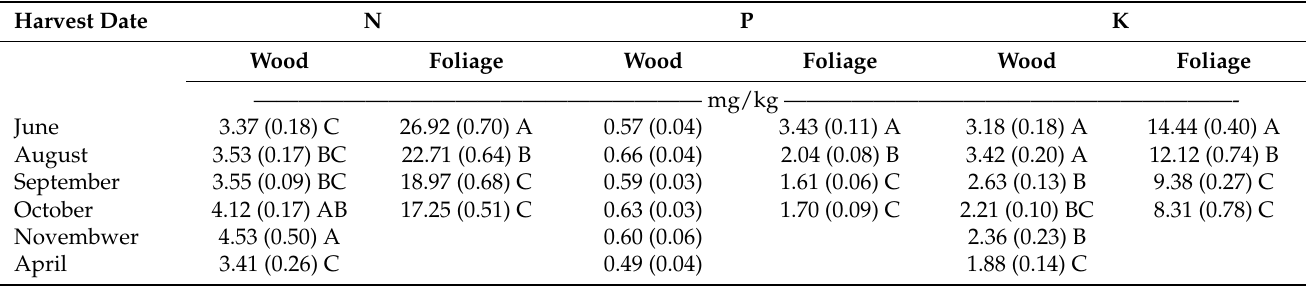
Table 5. Summary of wood and foliage nitrogen nutrient concentrations for time of harvest treatment main effects. Letters indicate significant differences within columns at the alpha = 0.05